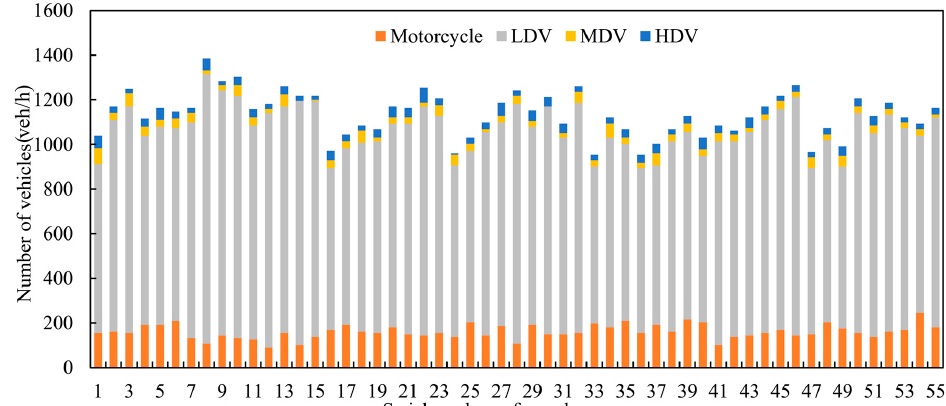
Figure 5. Number of vehicles per hour (veh/h).